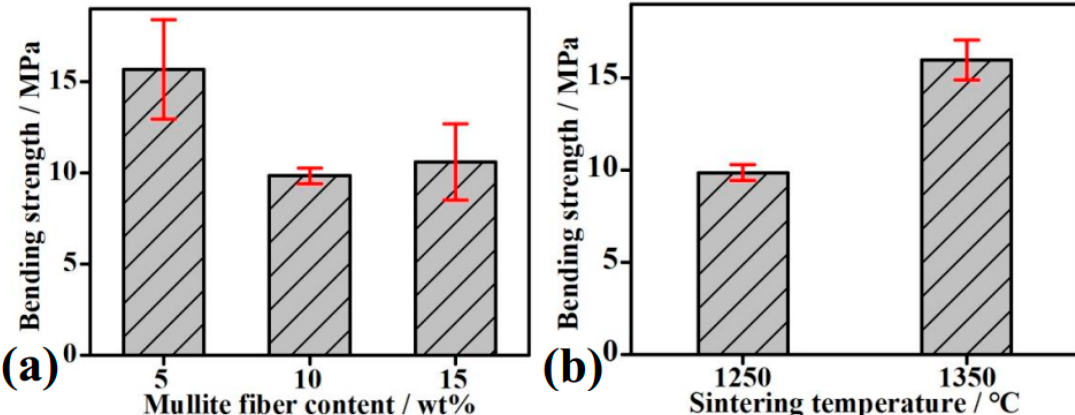
Figure 8. Bending strength of MF/HA composites: ( a ) with 5 wt %, 10 wt %, and 15 wt % MF addition; ( b ) sintering at 1250 ◦ C and 1350 ◦ C with 10 wt % MF addition.